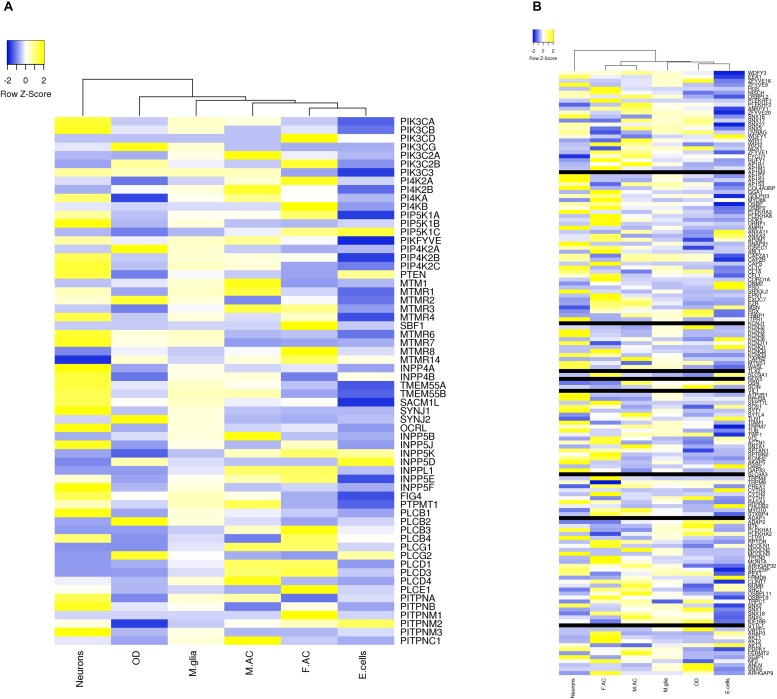
Expression level of phosphoinositide signaling genes in various brain cell types. The expression of genes involved in phosphoinositide signaling in specific neural cell types in human brain is shown. The data has been compiled from BrainRNAseq. The expression values range from –2 to 2 (Blue to Yellow). Black bar represents genes whose expression values were not available in the data set. The different cell types represented are Neurons, Oligodendrocytes (OD), Microglia (M.glia), Mature astrocytes (M.AC), Fetal astrocytes (F.AC) and Endothelial cells (E.cells). (A) Represents expression values of kinases, phosphatases, phospholipases and lipid transfer protein and (B) represents expression values of lipid binding proteins.